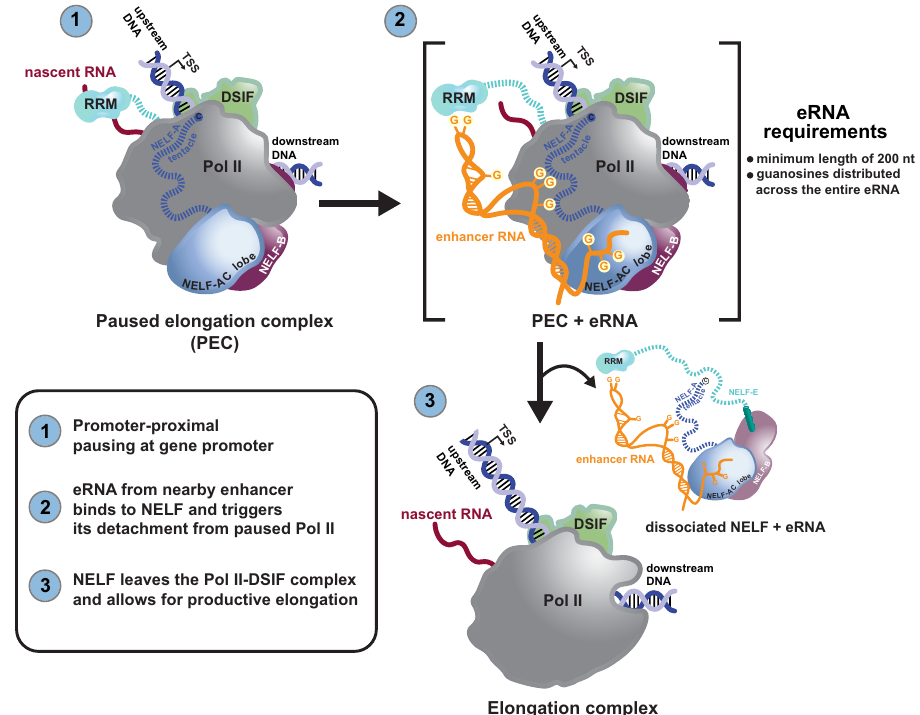
Fig. 8 Model of how multivalent, allosteric interactions between an eRNA and the paused elongation complex (PEC) stimulate Pol II pause release. Following the transcription of a nearby, activated enhancer, an eRNA molecule contacts the paused elongation complex (consisting of Pol II, DSIF, and NELF) at the target gene promoter. The eRNA interacts with NELF at multiple sites (positive patches on NELF-AC, the NELF-A and -E tentacles, and the NELF-E RRM domain). These multivalent, allosteric interactions collectively trigger NELF detachment from the PEC. The resulting elongation complex (consisting of Pol II and DSIF) then resumes transcription elongation. The length of the eRNA (>200) and unpaired guanosines within an eRNA are essential for its ability to detach NELF from the